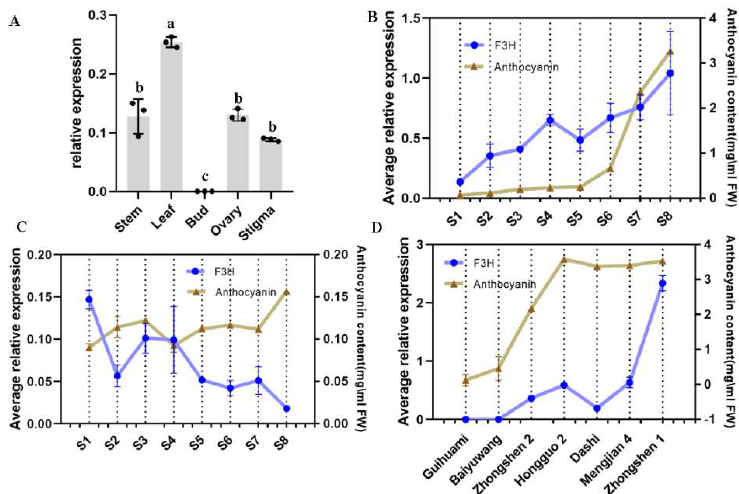
Figure 4. F3H expression profiles and anthocyanin content in mulberry: ( A ) Expression profiles of F3H in different organs in mulberry. ( B ) F3H expression level and anthocyanin content during fruit ripening process in Zhongshen 1. ( C ) F3H expression level and anthocyanin content during fruit ripening process in fruits at eight different development stages in LvShenZi. ( D ) F3H expression levels in ripe fruits of different mulberry varieties. The significance is indicated by different letters ( p <